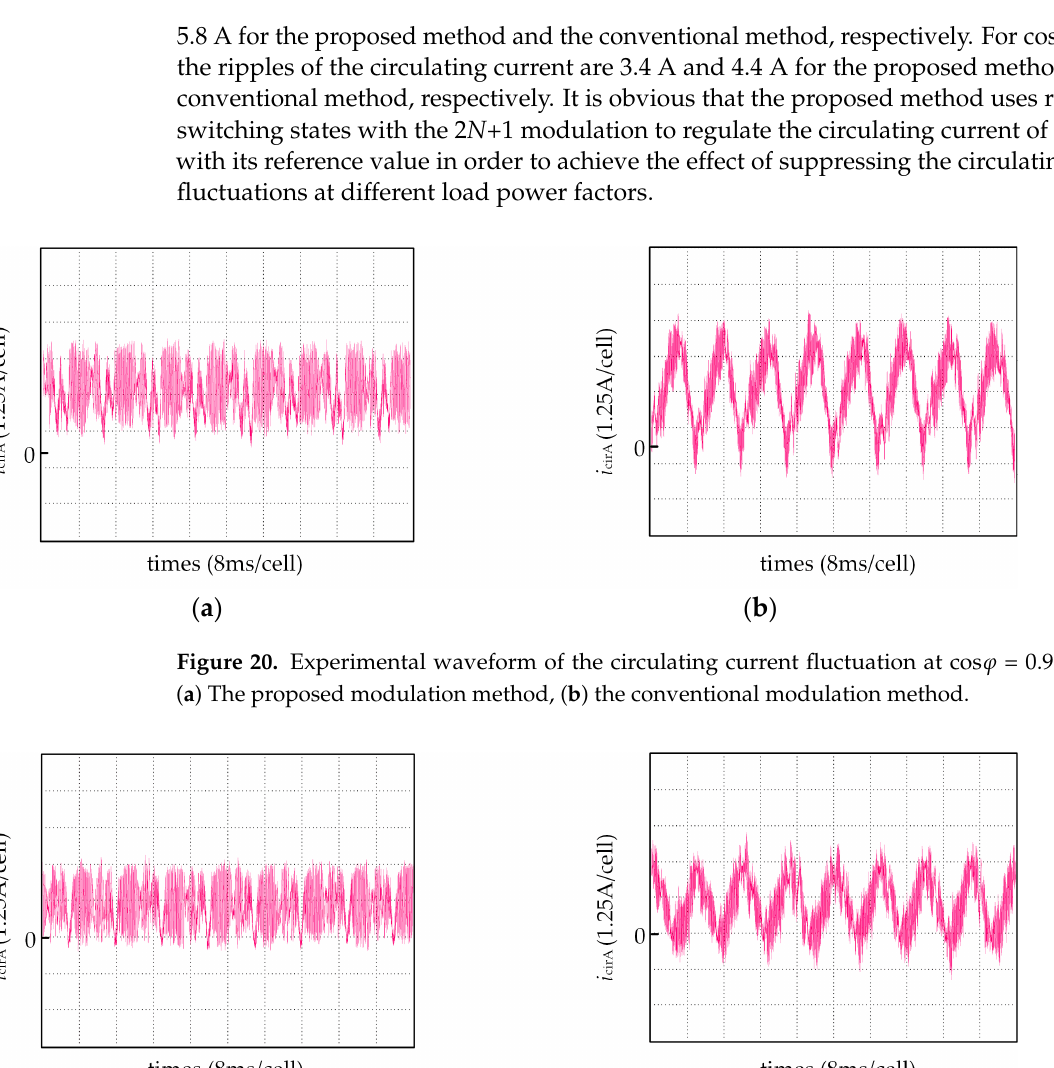
( b ) Figure 19. The total harmonic distortion of the output current at cos φ = 0.623 ( N = 8). ( a ) The proposed modulation approach, ( b ) the conventional modulation approach.